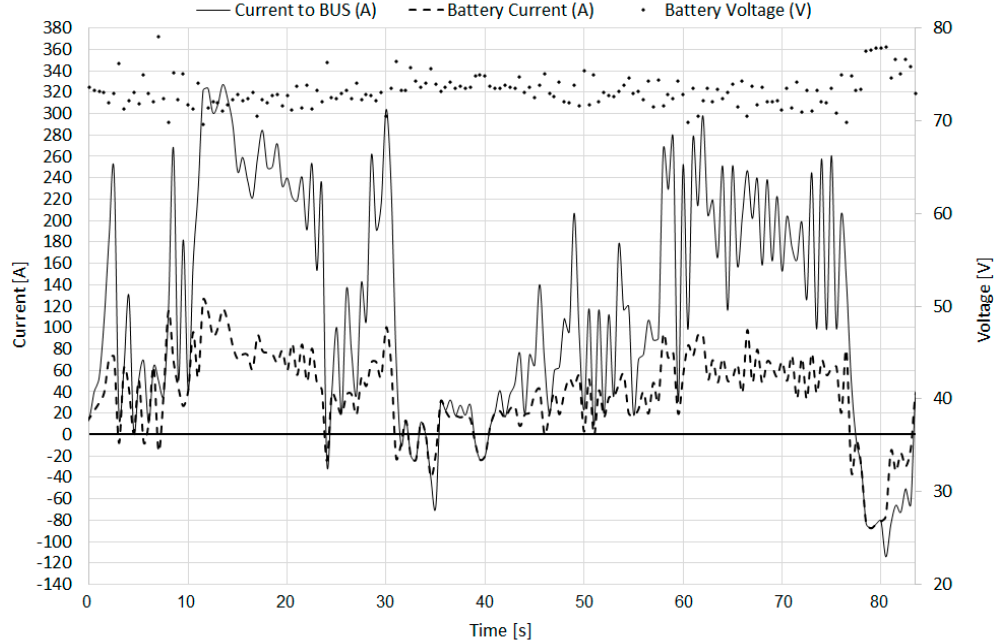
Figure 11. Battery voltage and current trends.